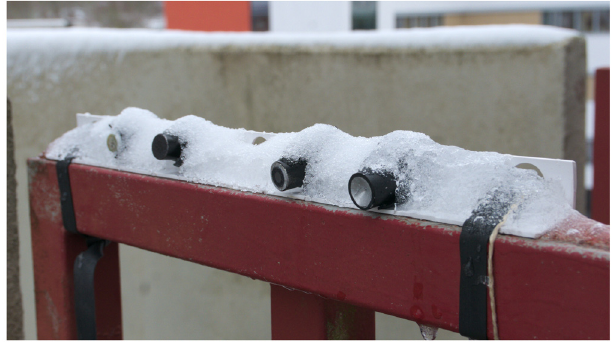
Figure 2. Different microphone prototypes exposed to outdoor conditions during winter 2018 in